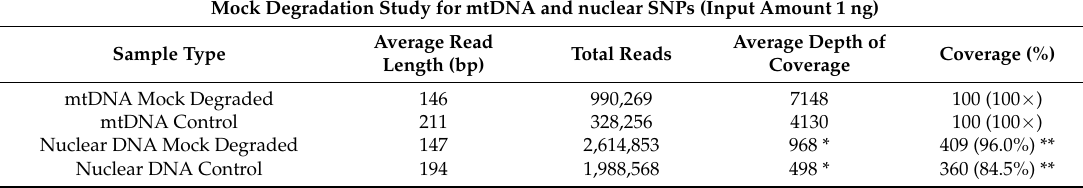
Table 4. Sequencing statistics for mock degraded and control samples at 1 ng.